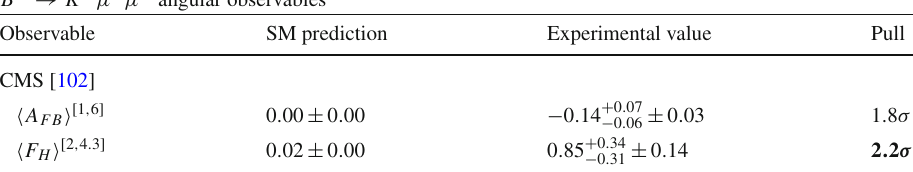
of B + → K + μ + μ − included in the global